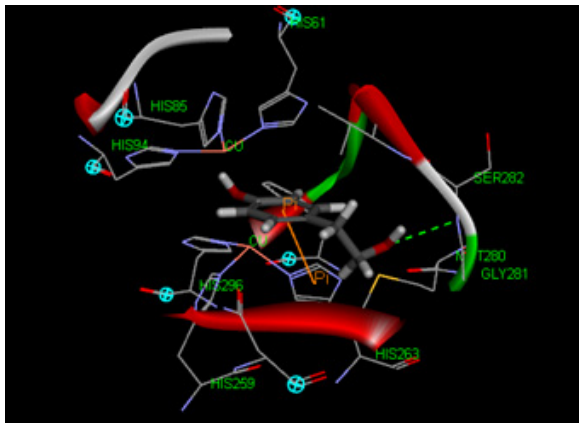
Figure 10. Docking of tyrosol ( 1 ) into the active site of mushroom tyrosinase. The OH moiety of tyrosol introduced one hydrogen bond with SER282 (green dot line) and its aromatic ring interacted with HIS263 by π – π interaction (orange line). Three histidine residues coordinated each copper